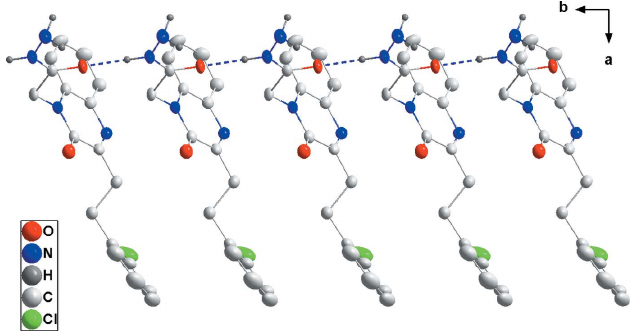
Figure 2 Chains of molecules formed along b by N—H (cid:2)(cid:2)(cid:2) O hydrogen bonds.